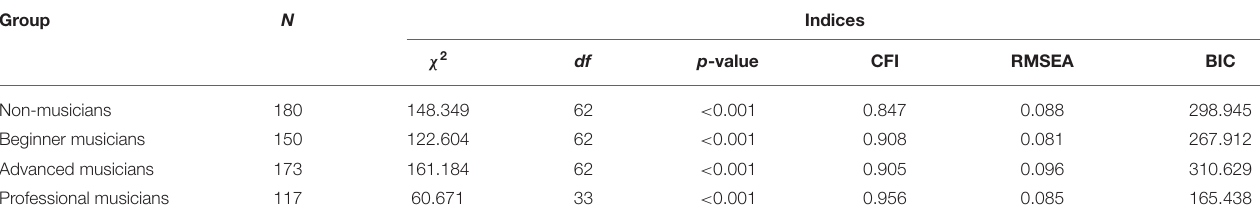
TABLE 15 | Fit indices of path analyses of structural models on multiple groups based on musicianship. Group